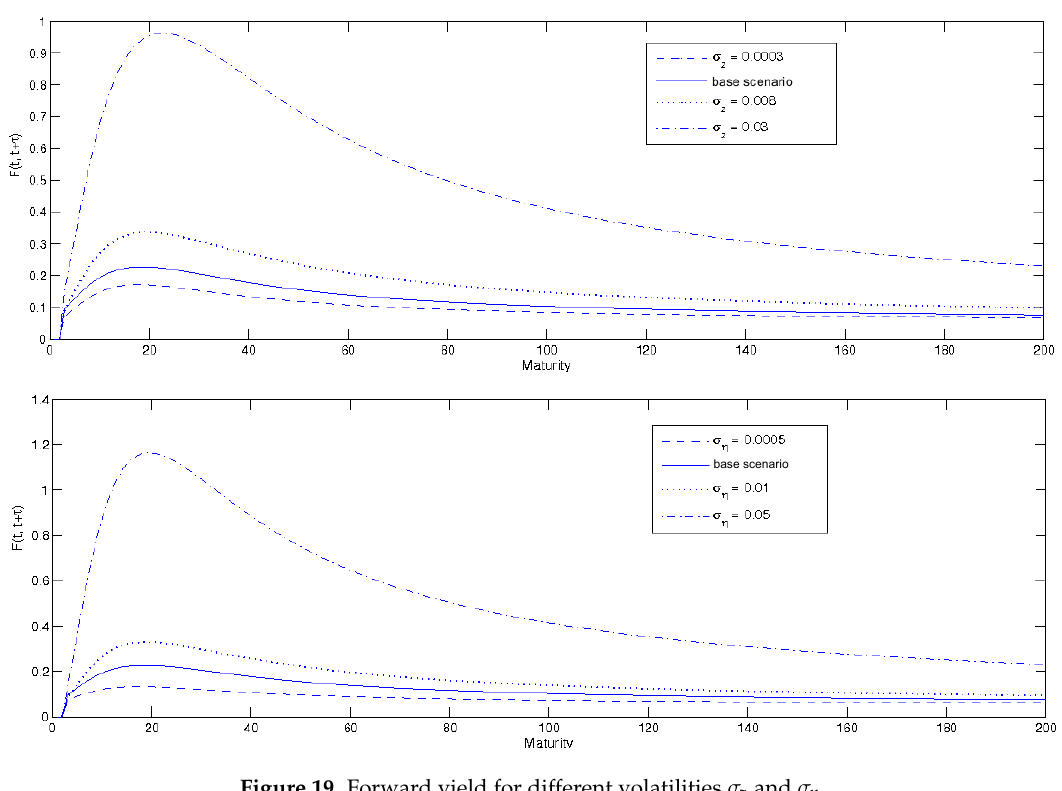
Figure 19. Forward yield for different volatilities σ z and σ η .